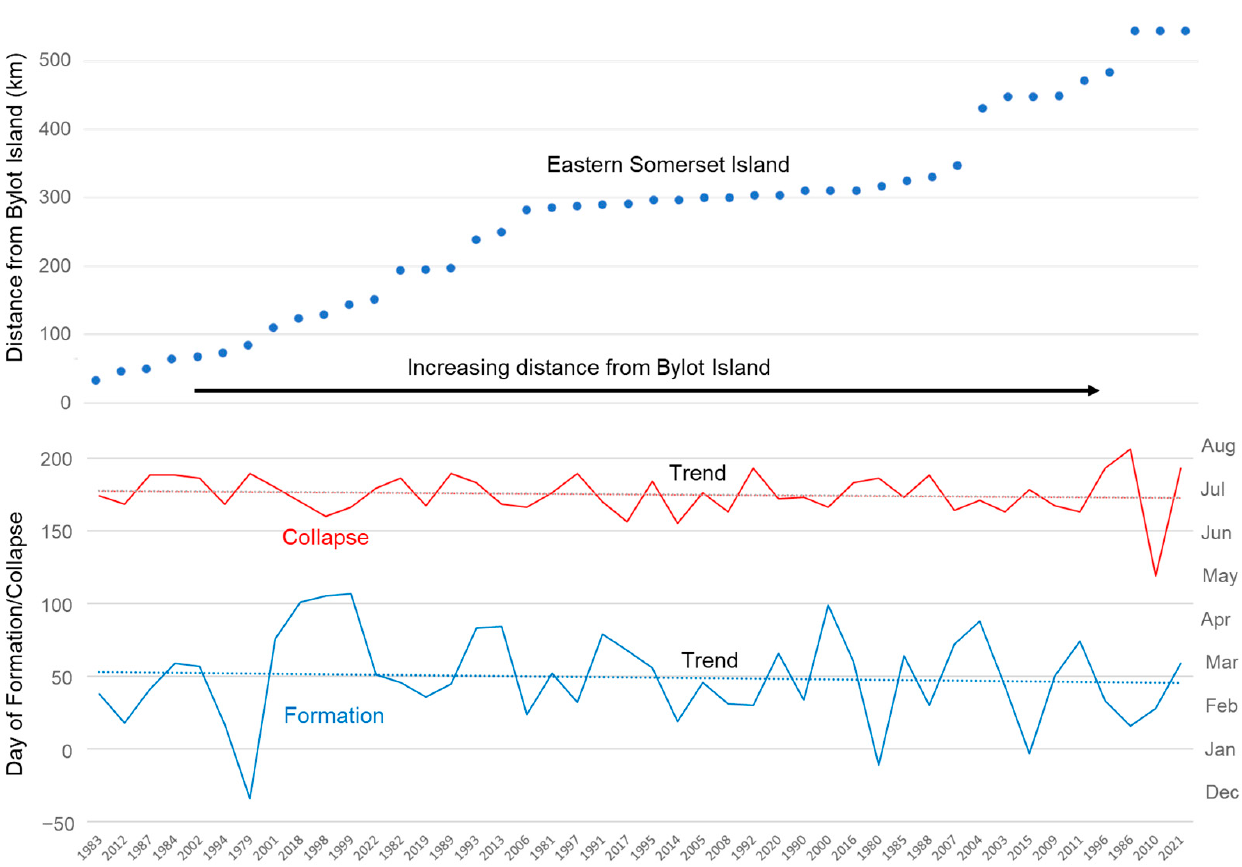
Figure 10. Distance of the Lancaster Sound ice arch from Bylot Island (top of graph) in ascending order is compared to ice arch formation and collapse (bottom of graph). Correlation and linear trends are insignificant, implying that the location of the ice arch has no effect on the timing and duration of the structure.